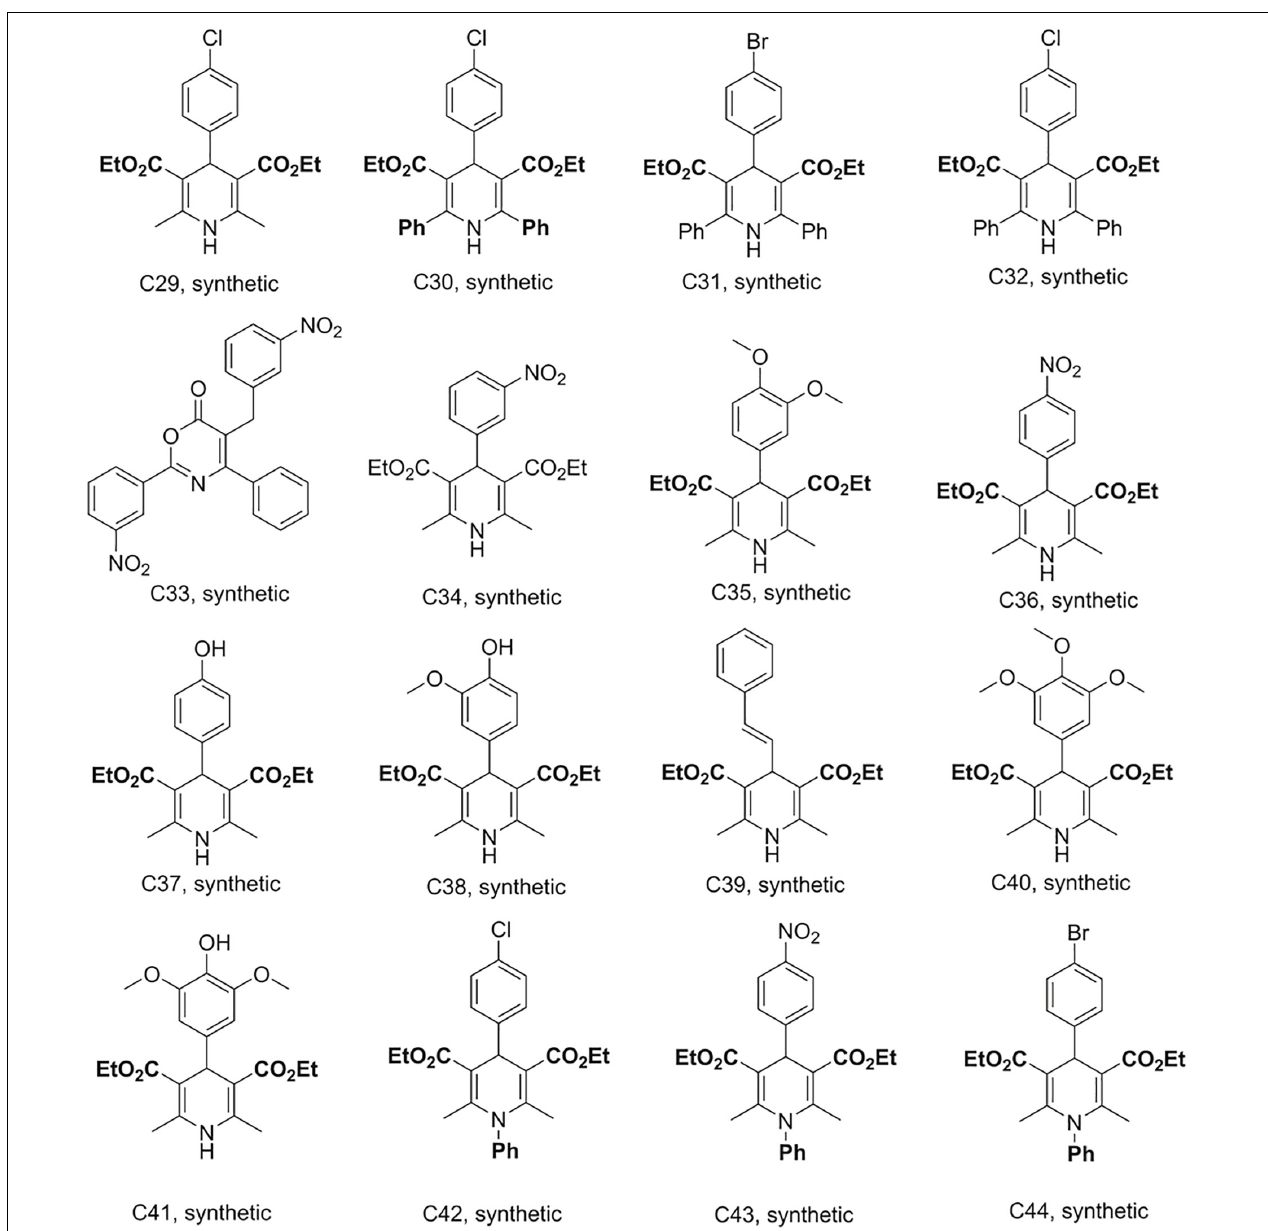
FIGURE 3 | Structures of the compounds tested for anti -M. tuberculosis activity: Dihydropyridines C29–C44 (Sandjo et al., 2016a; Pollo et al.,